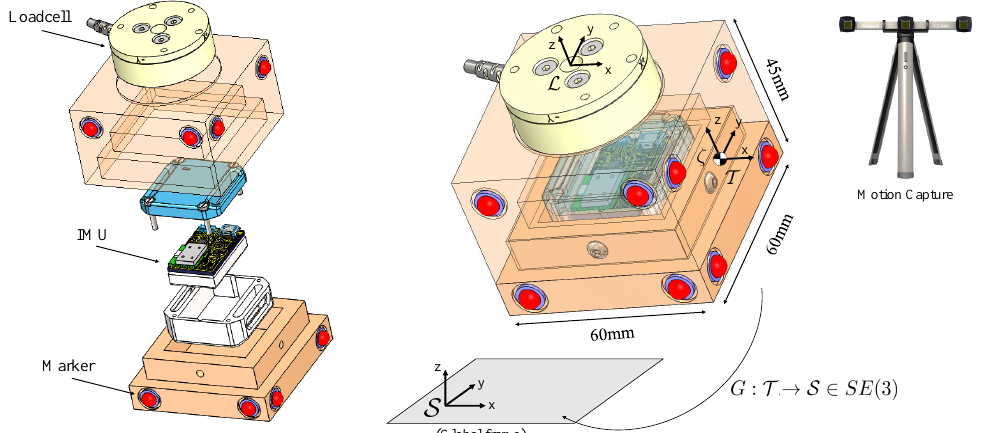
Figure 1. Conceptual design of the instrumented box: a loadcell attached on the top of the box; the inertial measurement unit (IMU) is located inside, at the center while the infrared markers allow capturing 3D position and orientation of the box. Attaching markers on the top and side of the tool. Assuming that the marker’s position on the tool is known from the computer-aided design (CAD)